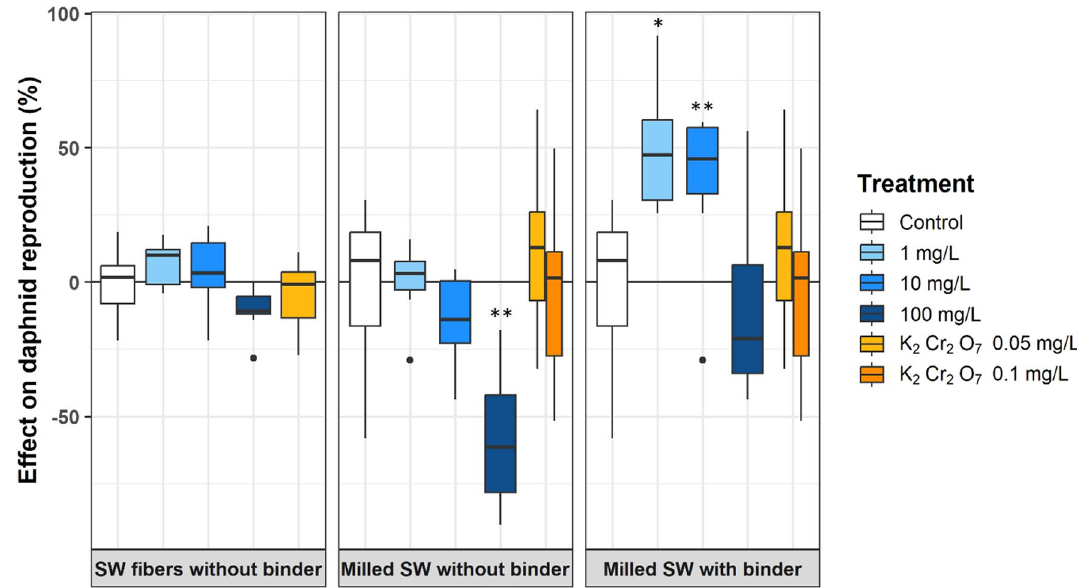
Fig. 6 Chronic effects (21 d) on D. magna reproduction for the negative control (white), the eluates of three concentrations (1, 10 and 100 mg/L) of each of the three test materials (blue colors) and the positive control (potassium dichromate; orange colors) as boxplots. Boxes depict the lower and upper quartile as well as the median; whiskers show the standard deviation of mean of n 10 replicates and dots represent outliers. Effects were = calculated in comparison to the mean number of offspring in the negative control and positive effect values show reproduction stimulation, while negative values show reproduction inhibition. Asterisks denote significant differences between the treatments and the negative control (Dunn´s test: *: p < 0.05, **: p <